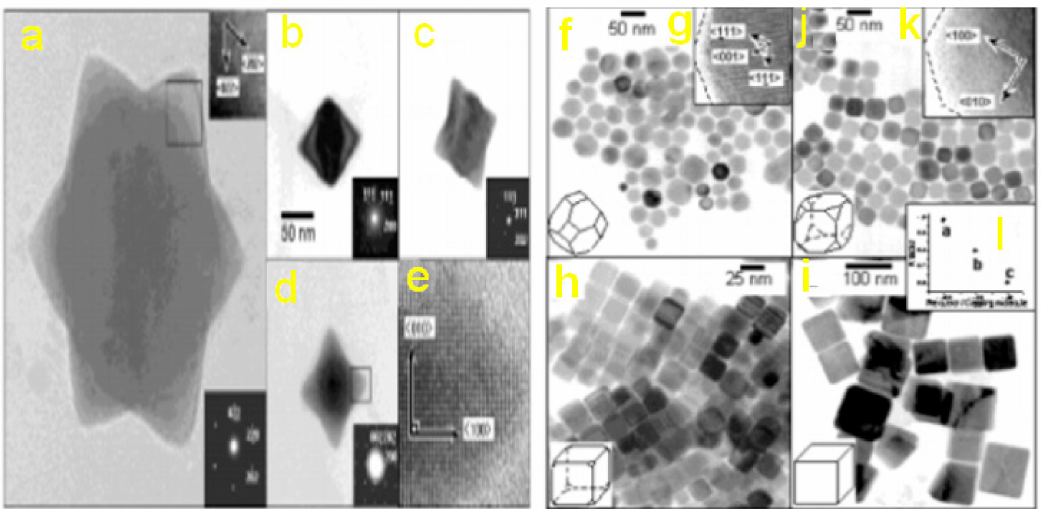
Figure 7. ( a ) TEM image of star-shaped PbS nanocrystals synthesized at 230 ◦ C. (Inset) HRTEM image of lattice fringes with zone axis of (111). ( b – d ) TEM images and electron di ff raction patterns with zone axis of ( b ) (110), ( c ) (112) and ( d ) (100), respectively. ( e ) HRTEM image of zoomed fringes with zone axis of (100). ( f – h ) Dodecanethiol (DT) capping molecular system. The ratio of precursor to capping molecules is ( a ) 1 / 400, ( b ) 1 / 100 and ( c ) 1 / 50, respectively. ( i ) Dodecylamine (DDA) capping molecular system with the ratio of precursor to capping molecule of 1 / 100. ( j ) HRTEM image of a round truncated octahedron with zone axis of (110), and ( k ) a truncated octahedron with zone axis of (100). ( l ) The R factor depends on the relative ratio of precursor to capping molecules (reproduced from ref. [63] with permission from the American Chemical